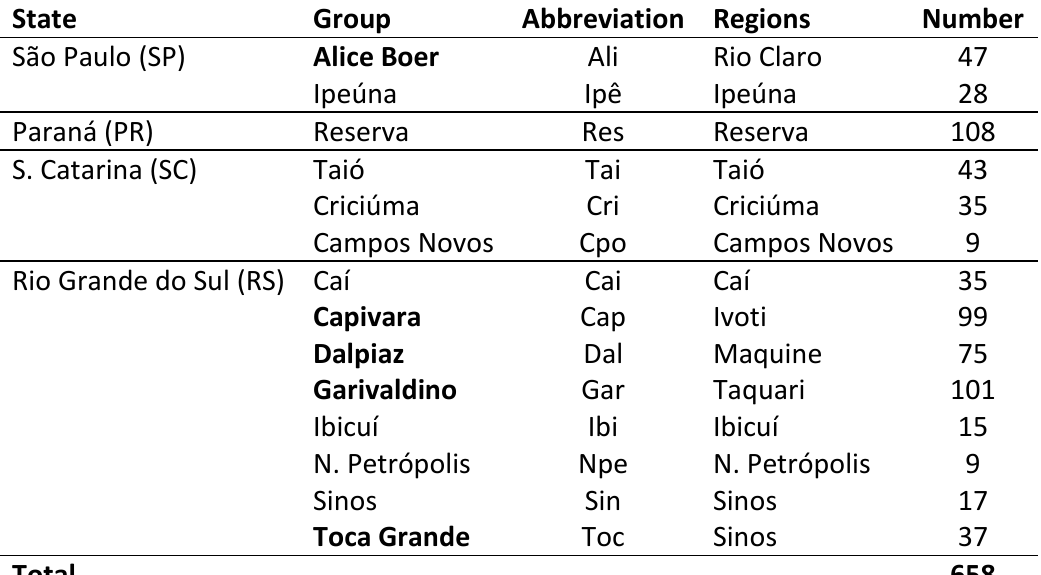
Figure 3: Map presenting the geographic location of the analysed groups. Table 2: Geographic origin and number of points included in the analysis. Group names in bold refer to groups composed exclusively of points of a single archaeological site, in this case, it was decided to name the group according to the name of the archaeological